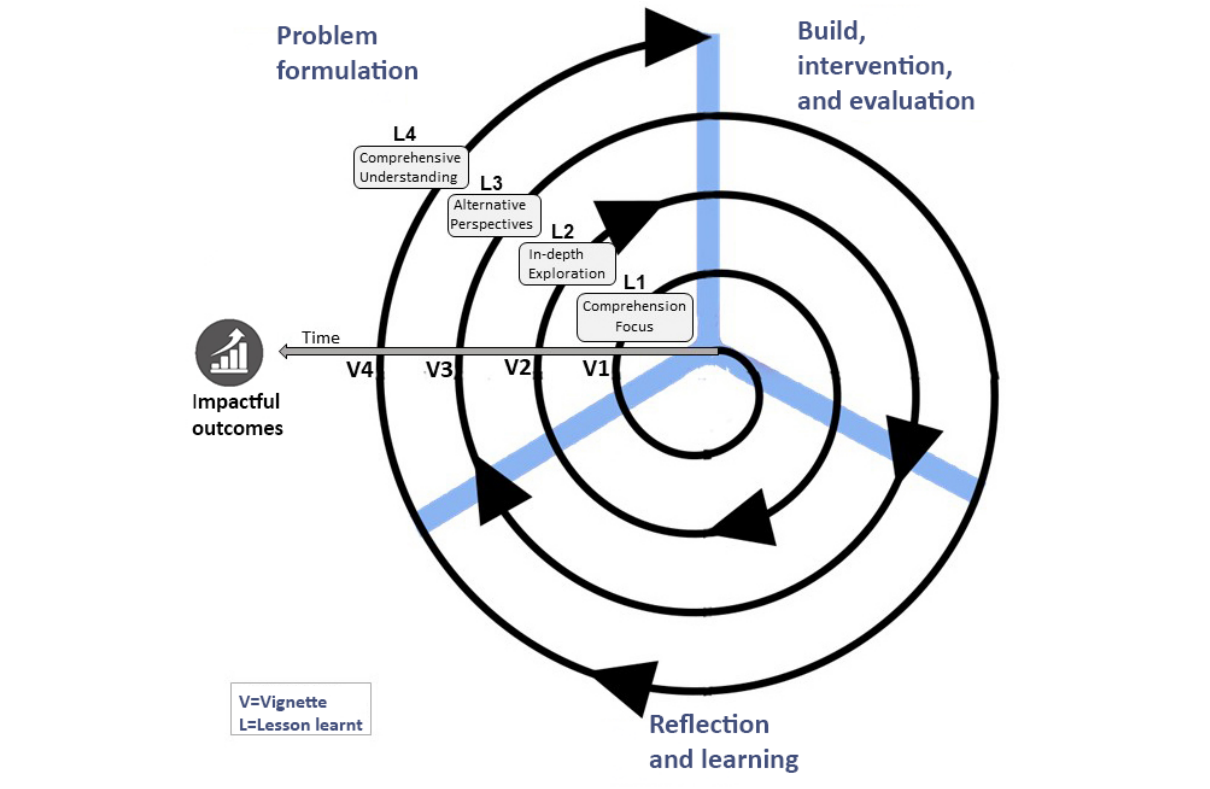
Figure 9. Visualization of reflection within the context of the action design research